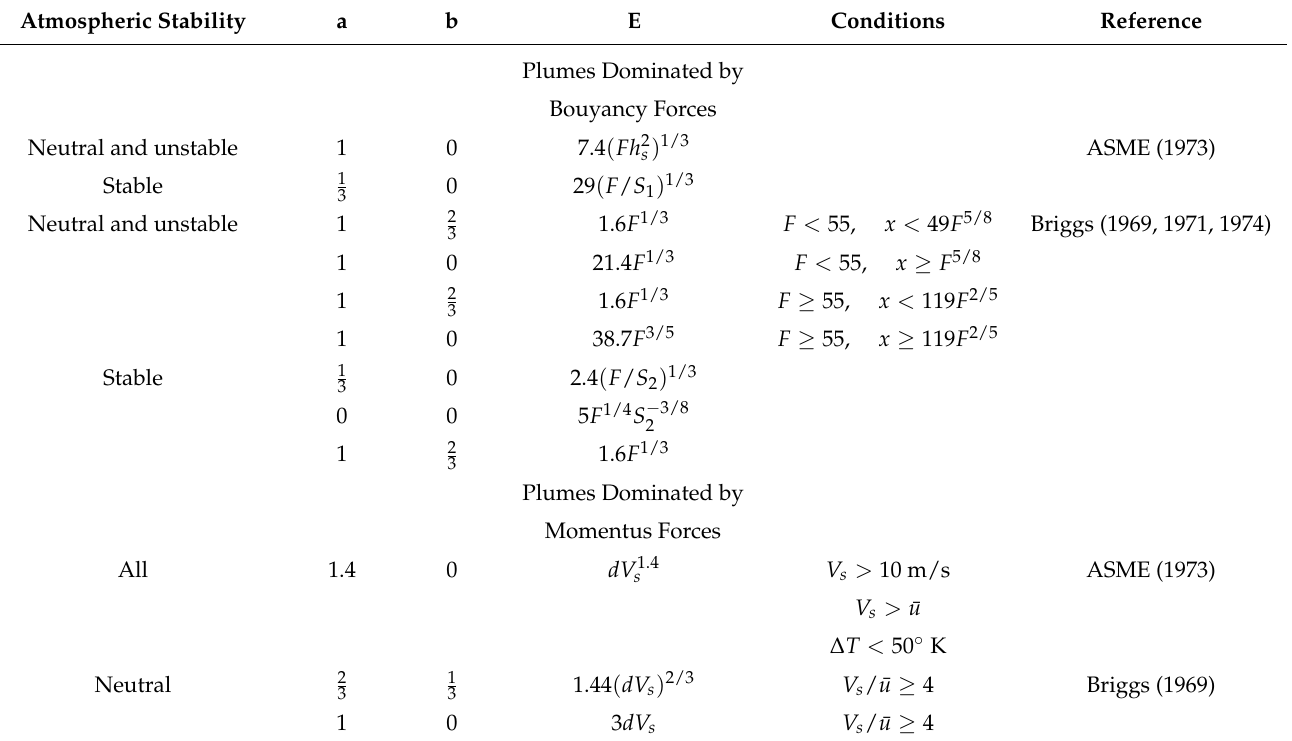
Atmospheric Stability